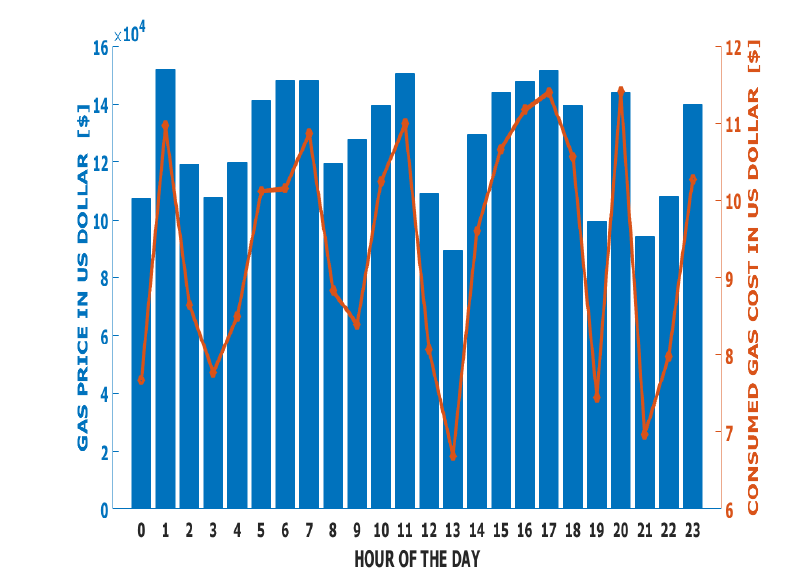
Figure 7. On-chain DC-OPF solution, execution cost in US Dollars, according to gas price fluctuation on 15 May